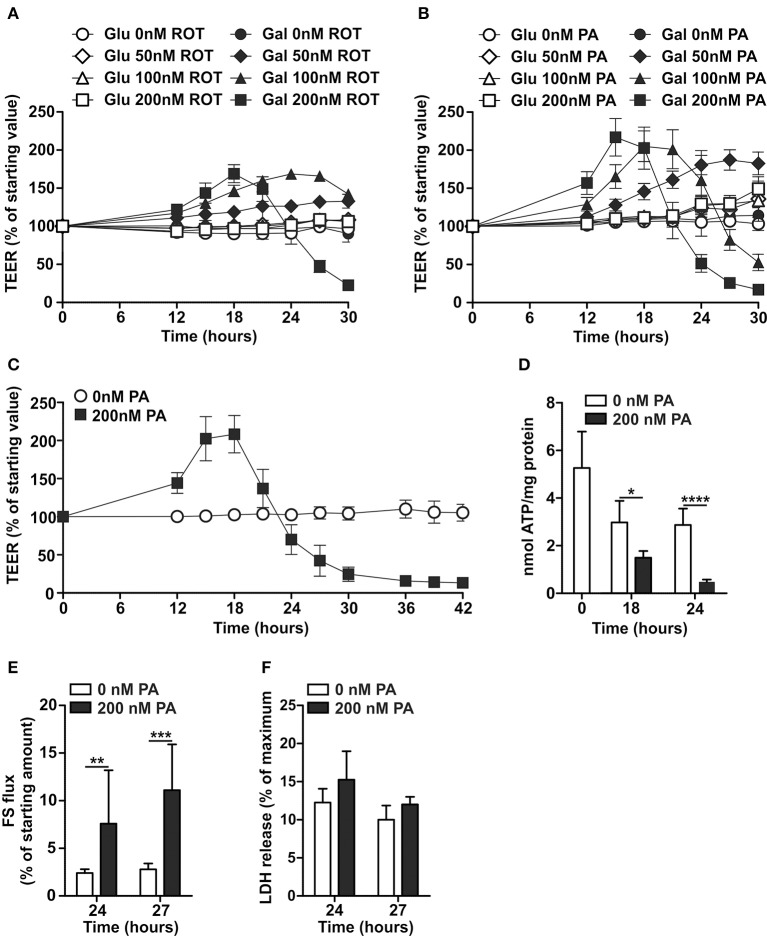
Effects of Complex I inhibition on differentiated Caco-2 cell monolayers cultured in glucose- and galactose-containing medium. Fourteen-days differentiated Caco-2 monolayers using DMEM-glucose (Glu) or DMEM-galactose (Gal) were incubated with vehicle (96% EtOH) or rotenone (ROT; 50–100–200 nM) or Piericidin A (PA; 50–100–200 nM) after which TEER was followed over time, (A,B) show representative examples of a single experiment and (C) the average of three independent experiments (only GAL ± 200 nM PA). Fourteen-days differentiated Caco-2 monolayers grown in DMEM-galactose were incubated with vehicle (96% EtOH) or 200 nM PA, after which (D) cellular ATP status, (E) fluorescein (FS) passage from the apical to the basolateral side of the monolayer, and (F) cytotoxicity by lactate dehydrogenase (LDH) release were determined. The results are expressed as a mean ± SD. The * symbol indicates statistical significance of P < 0.05, **P < 0.01, and ****P < 0.0001.